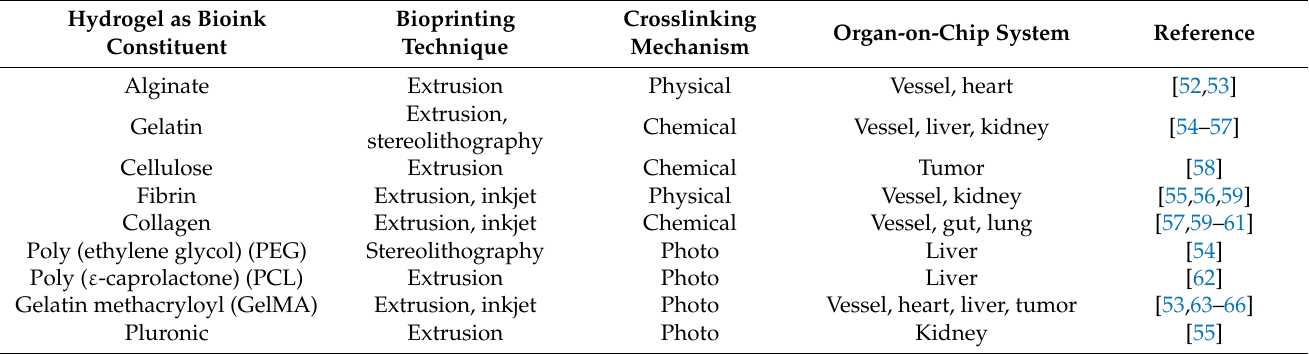
Table 1. List of studies using various hydrogels as bioink constituents.